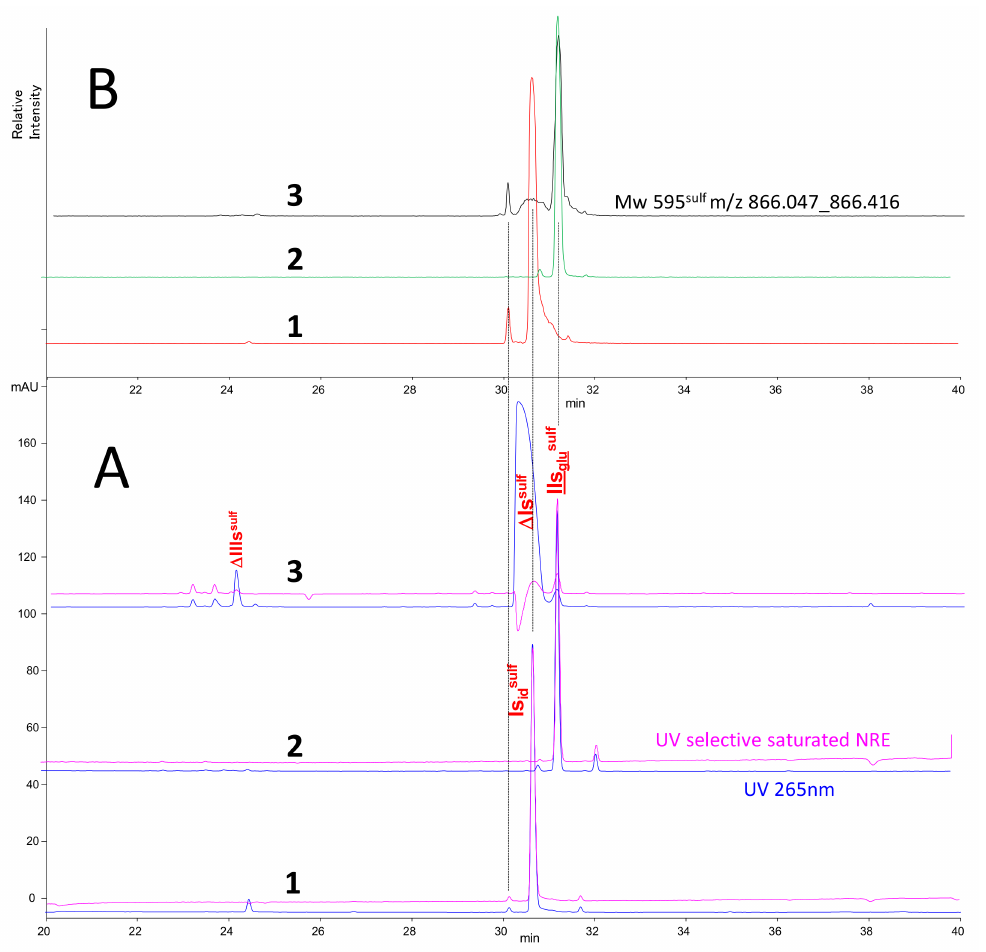
Figure 6. Chromatograms in ion pair chromatography of disaccharide NRE building blocks Is idsulf (1), IIs glusulf (2) compared to a sulfanilic tagged disaccharide fraction of porcine heparin digested by heparinase 1 (3). Detection: ( A ) UV — 265 nm; — 265 nm − 2.6 × 232 nm; ( B ) RIC Mw 595 sulf m / z 866.2, Peak assignment: IIs glusulf : GlcA-GlcN(NS,3S,6S)-SA, Is idsulf : IdoA(2S)-GlcN(NS,6S)-SA, ∆ IIIs sulf : ∆ HexUA(2S)-GlcN(NS)-SA, ∆ Is sulf : ∆